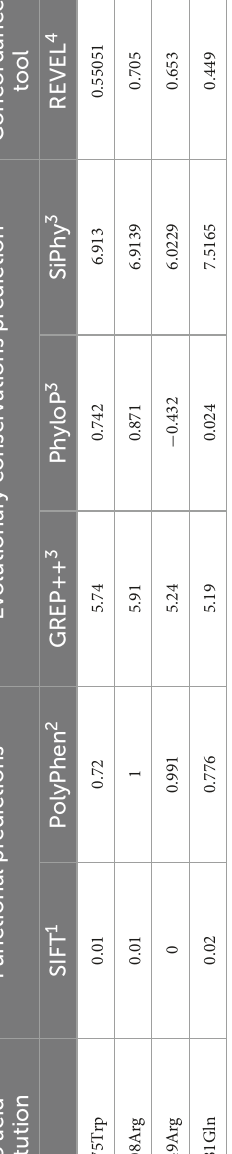
using MODELLER9v3 and Swiss Model server software. All the 100 models (output from MODELLER9v3) generated per each mutant category, were further subjected to energy minimization followed by PROCHECK validation. The mutant model (Gly908Arg and Arg675Trp) of NOD2 contains 95.2% residues in allowed regions and 4.8% in disallowed regions. The two mutant models (Gly149Arg, Arg381Gln) of IL23R consist of 94.2 and 96.8% of residues in the allowed region, whereas 5.8 and 3.2% of disallowed regions,